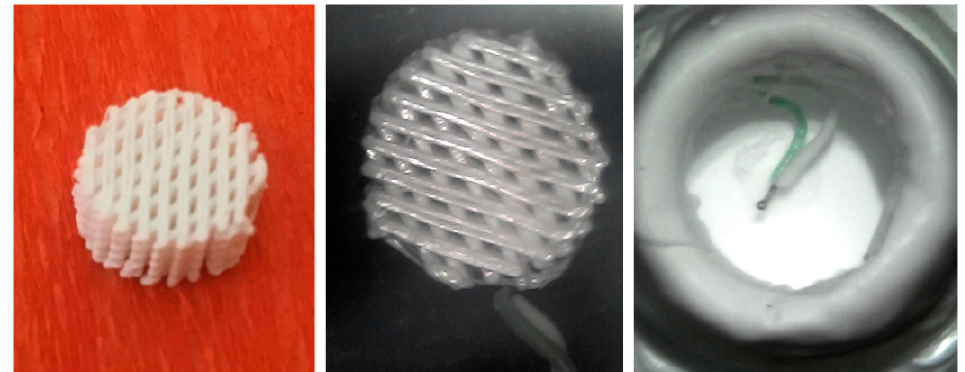
Figure 1. Typical image of a 3D printed porous structure (diameter of 10 mm, height of about 5 mm) ( left ); 3D porous structure incorporating a k-type thermocouple ( center ); hollow cylindrical Teflon mold equipped with k-type thermocouple ( right ).